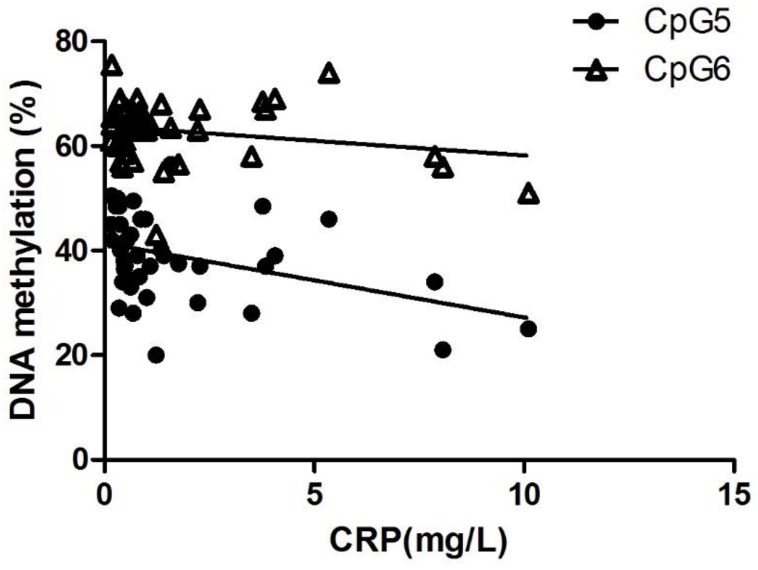
CpG5 methylation is inversely correlated with CRP concentration.Negative correlation between plasma CRP concentrations and CpG5 (p = 0.0096, r = -0.395, n = 42) and CpG6 (p = 0.1731, r = -0.214, n = 42) methylation in all participants (n = 14 young healthy controls, n = 9 age-matched healthy controls, n = 19 post-ACS patients).